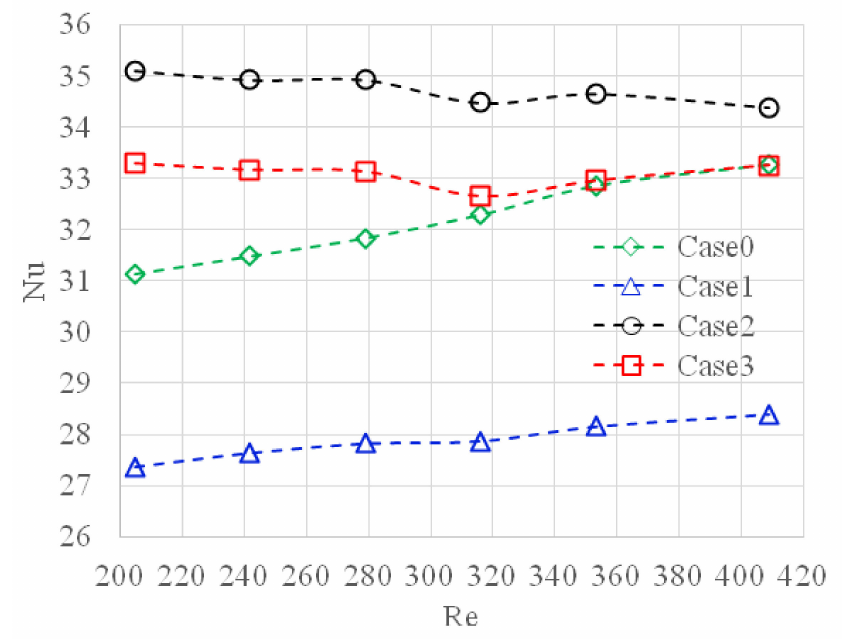
Figure 11. Variation of Nusselt number with Reynolds number for the different